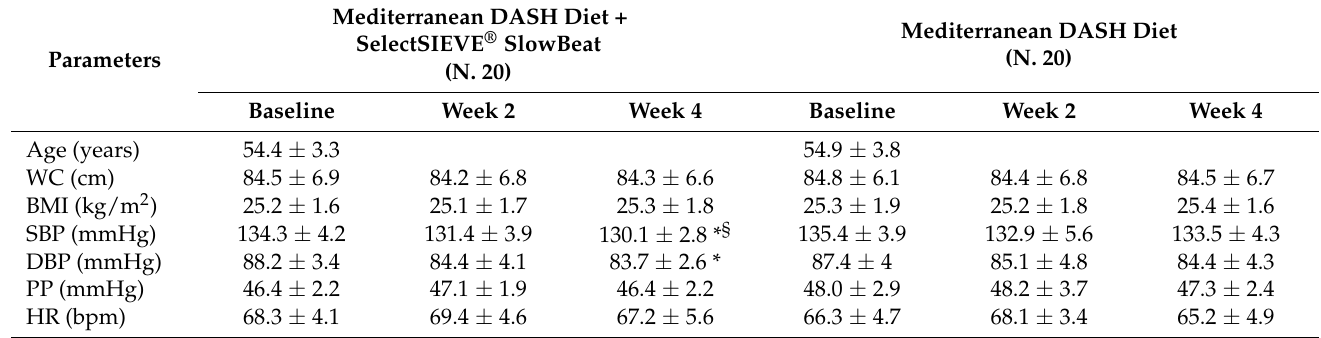
Table 2. Anthropometric and hemodynamic parameters from the baseline to the end of the study, reported as means and related standard deviations.